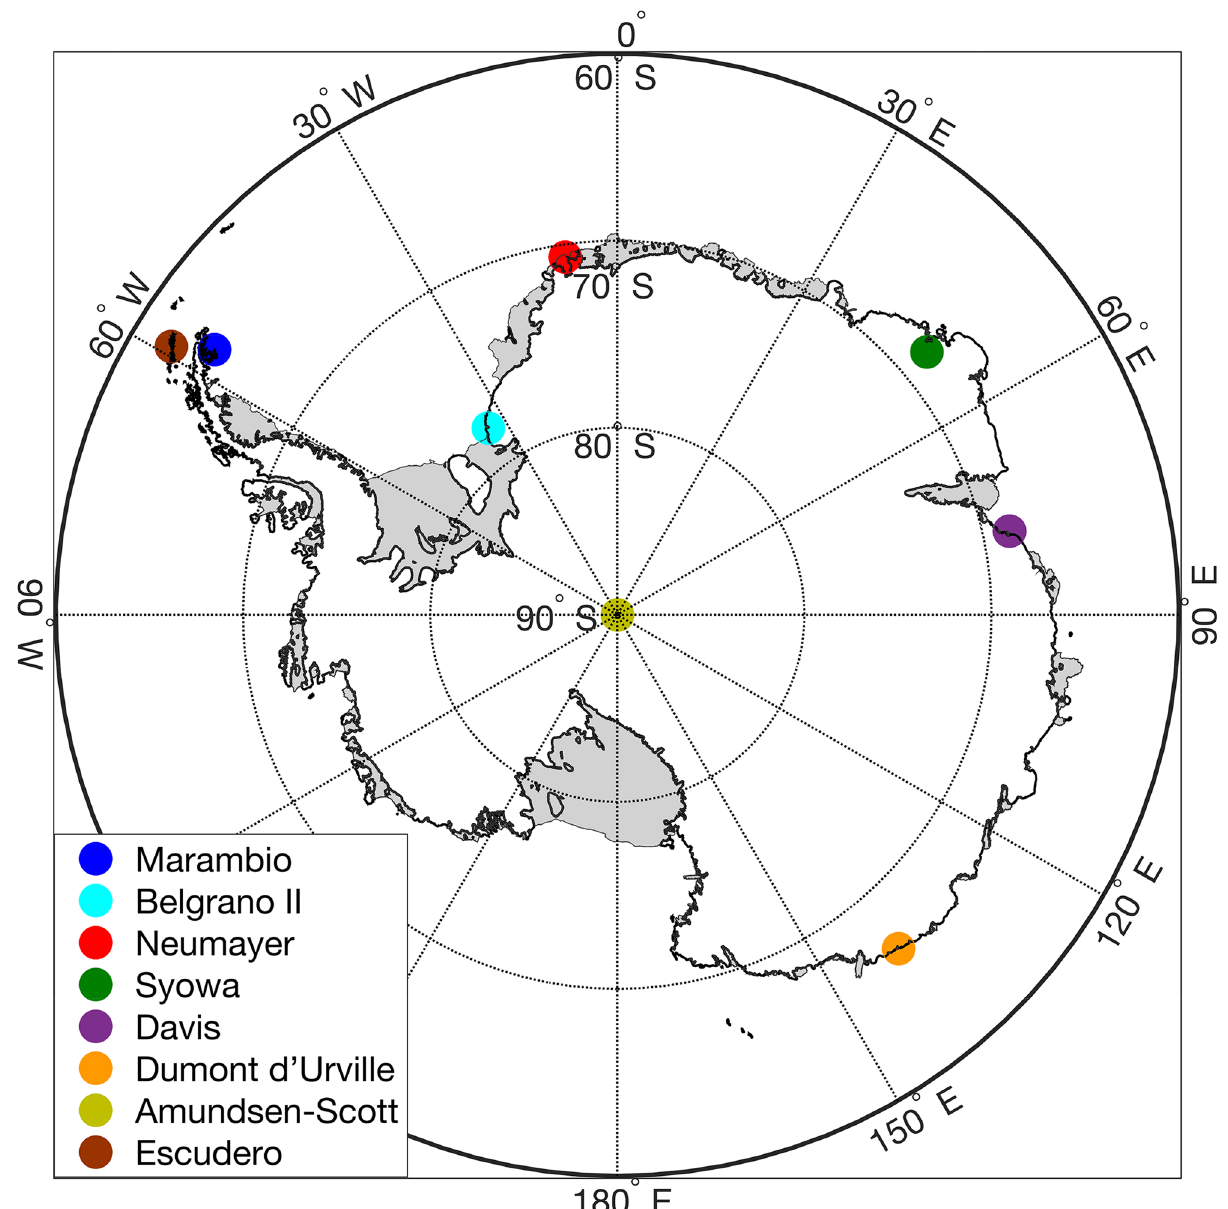
Figure 1. Balloon-borne ozonesonde launch sites. Map was generated by using Python’s Matplotlib Library (version 3.3.3; https ://matpl otlib .org/users /insta lling .html) 63